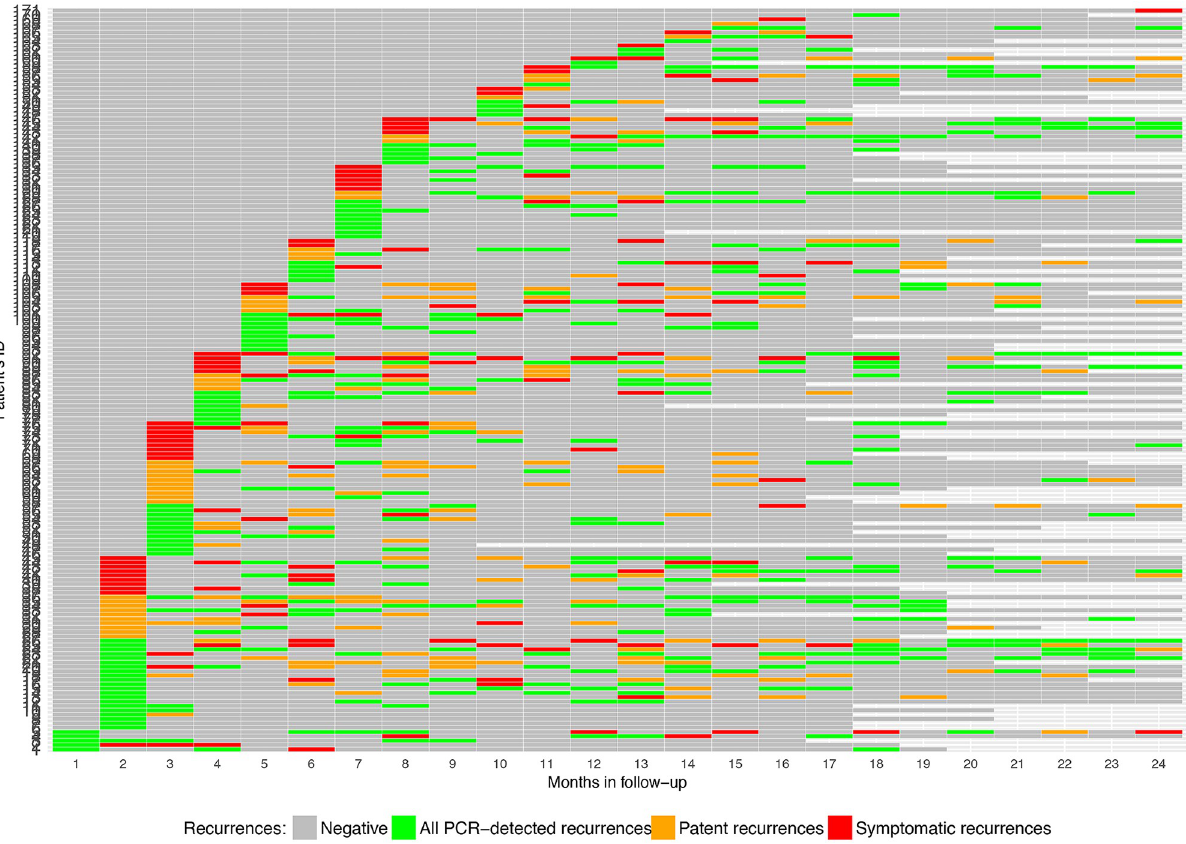
Fig 3. Heatmap of P . vivax recurrences by month of follow-up among the 171 cohort patients with at least one recurrence. ID, identifier; PCR, polymerase chain reaction.